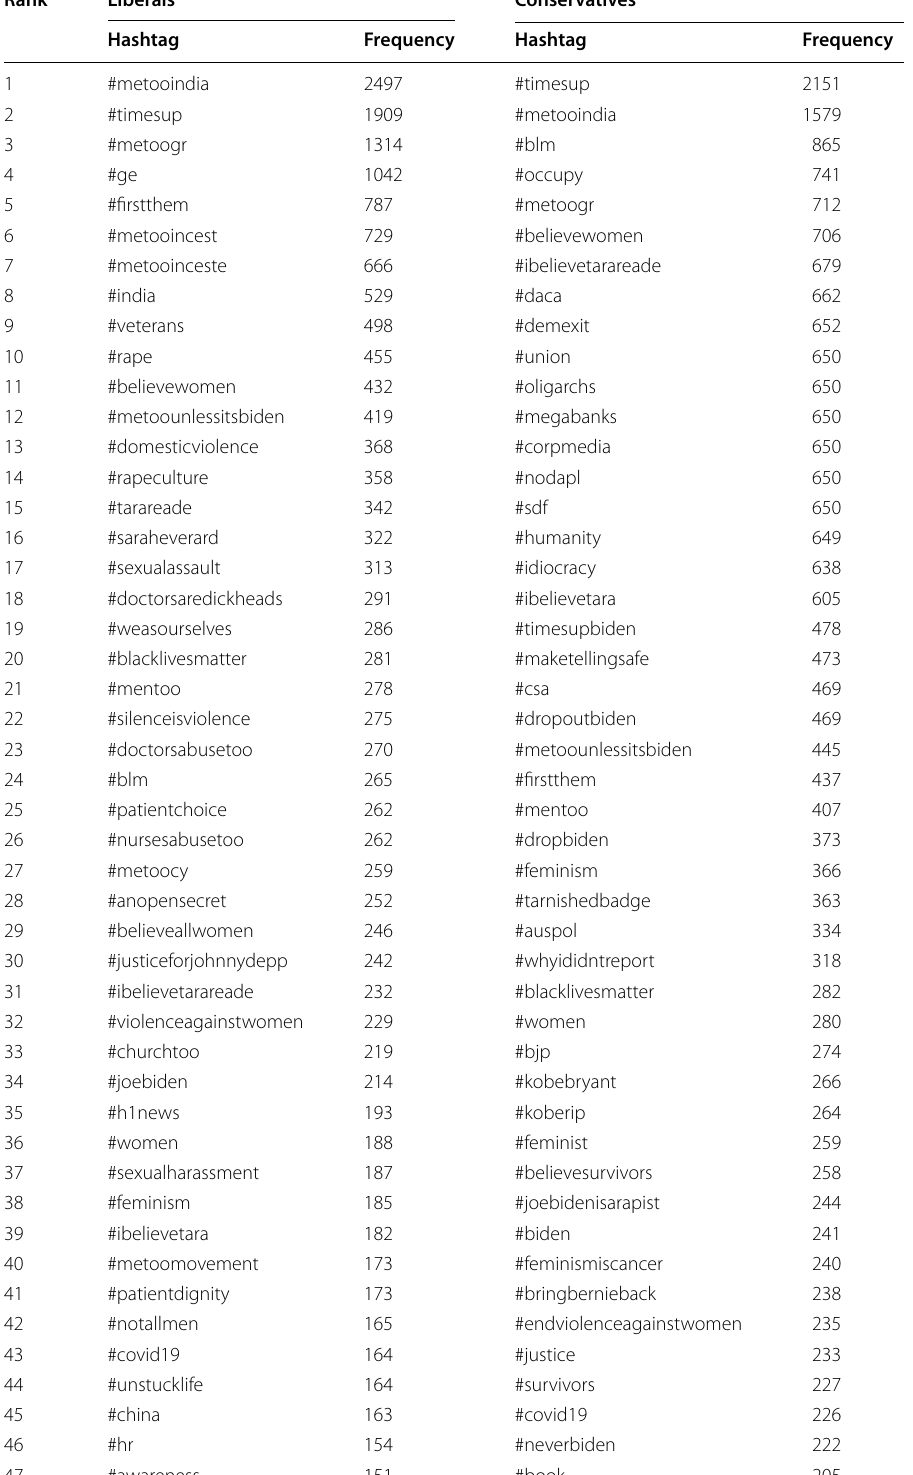
Table 9 Comparison of the top‑50 popular hashtags from the #metoo tweets posted by the users labeled as “liberals” and by “conservatives”,